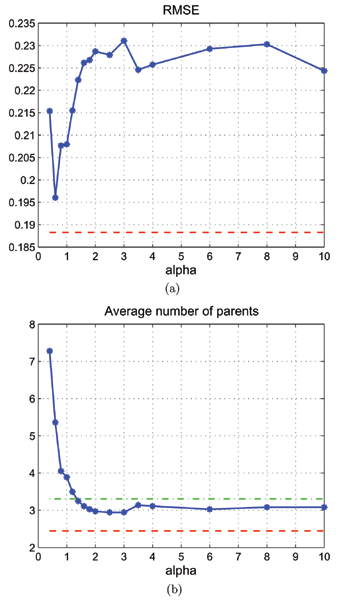
Goodness of fit and parsimony of the inferred models. Plots of the RMSE (a) and average number of parents per variable (b) for the nonlinear models, as a function of the parameter α of the hyperbolic tangent function (continuous blue curves); the dashed red curves refer to the RMSE and average number of parents for the linear regression model. The dash-dotted green curve in (b) represents the average number of parents in the differential equation model (i.e. the average number of true parents). Further analyses showed that, for α → + ∞, the RMSE saturates at 0.247, and the average number of parents saturates at 3.4.